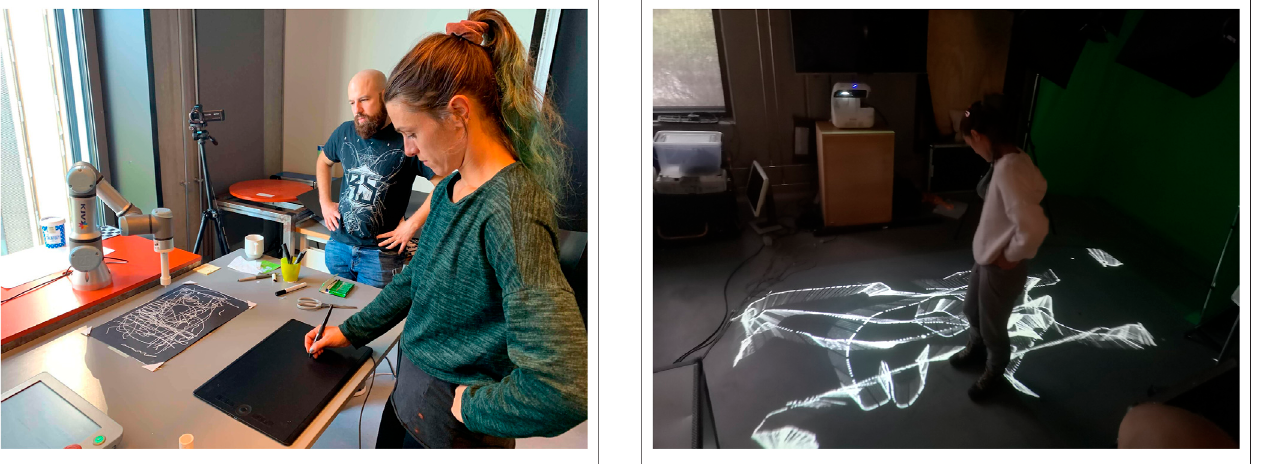
FIGURE 6 | The research team in a workshop at the HRI lab, experimenting with an early prototype of teleoperating the UR3 using a stylus and digital tablet.